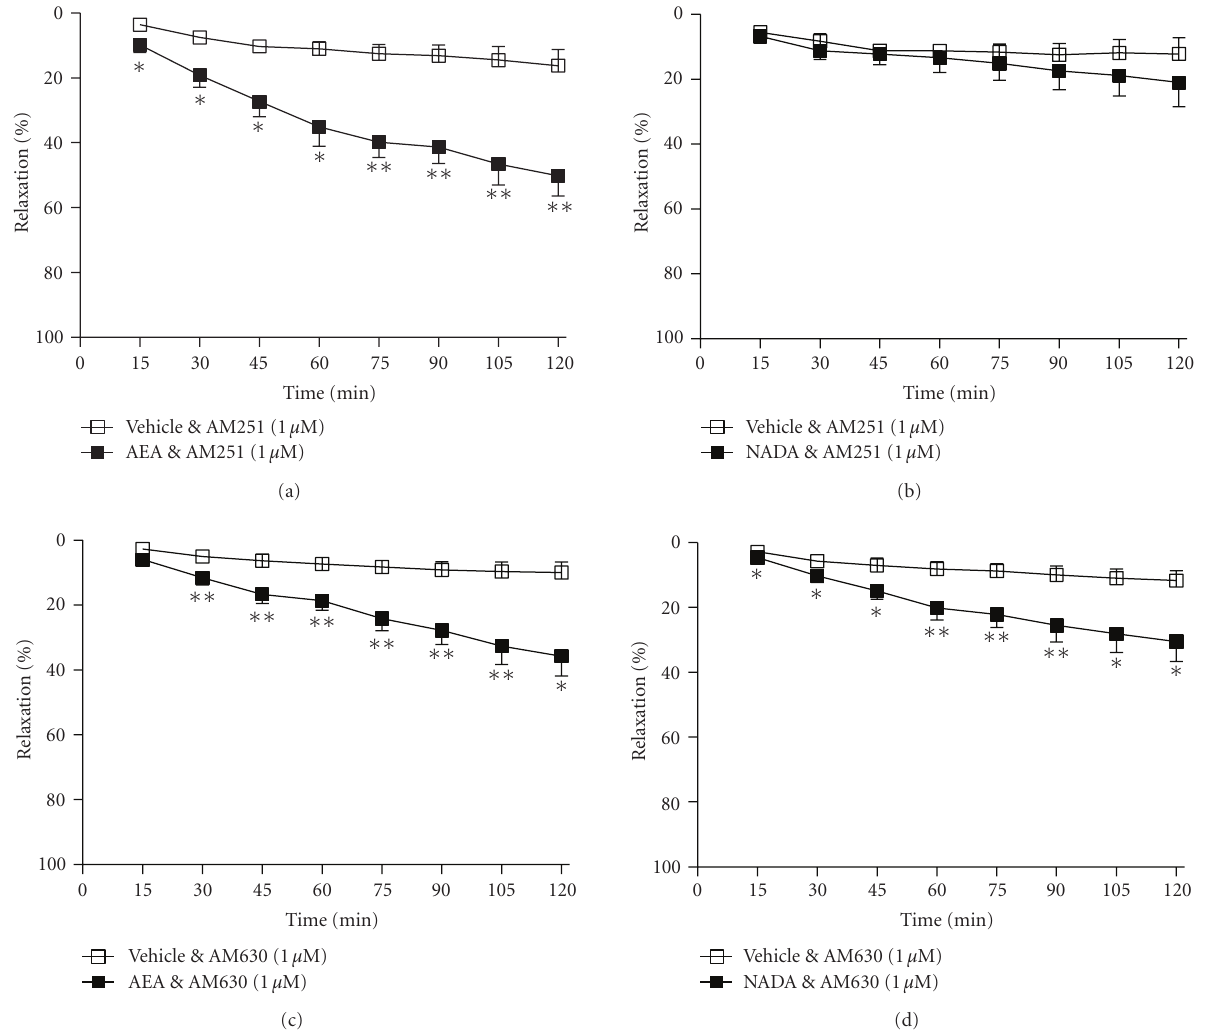
Figure 2: The e ff ects of the CB 1 receptor antagonist AM251 (1 μ M, (a), and (b)) and the CB 2 receptor antagonist AM630 (1 μ M, (c), and (d)) on vasorelaxation to anandamide and NADA. Data are given as means with error bars representing SEM. ( ∗ P < . 05, ∗∗ P < . 01, Student’s t